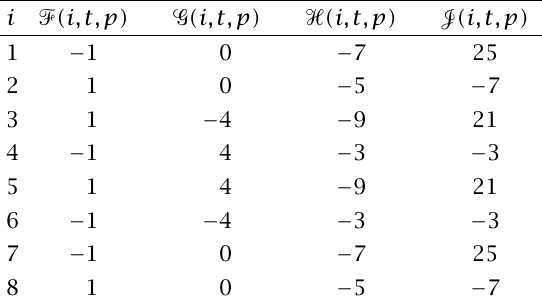
(cid:10) φ( − 1 ),φ(t),φ( 1 − t)